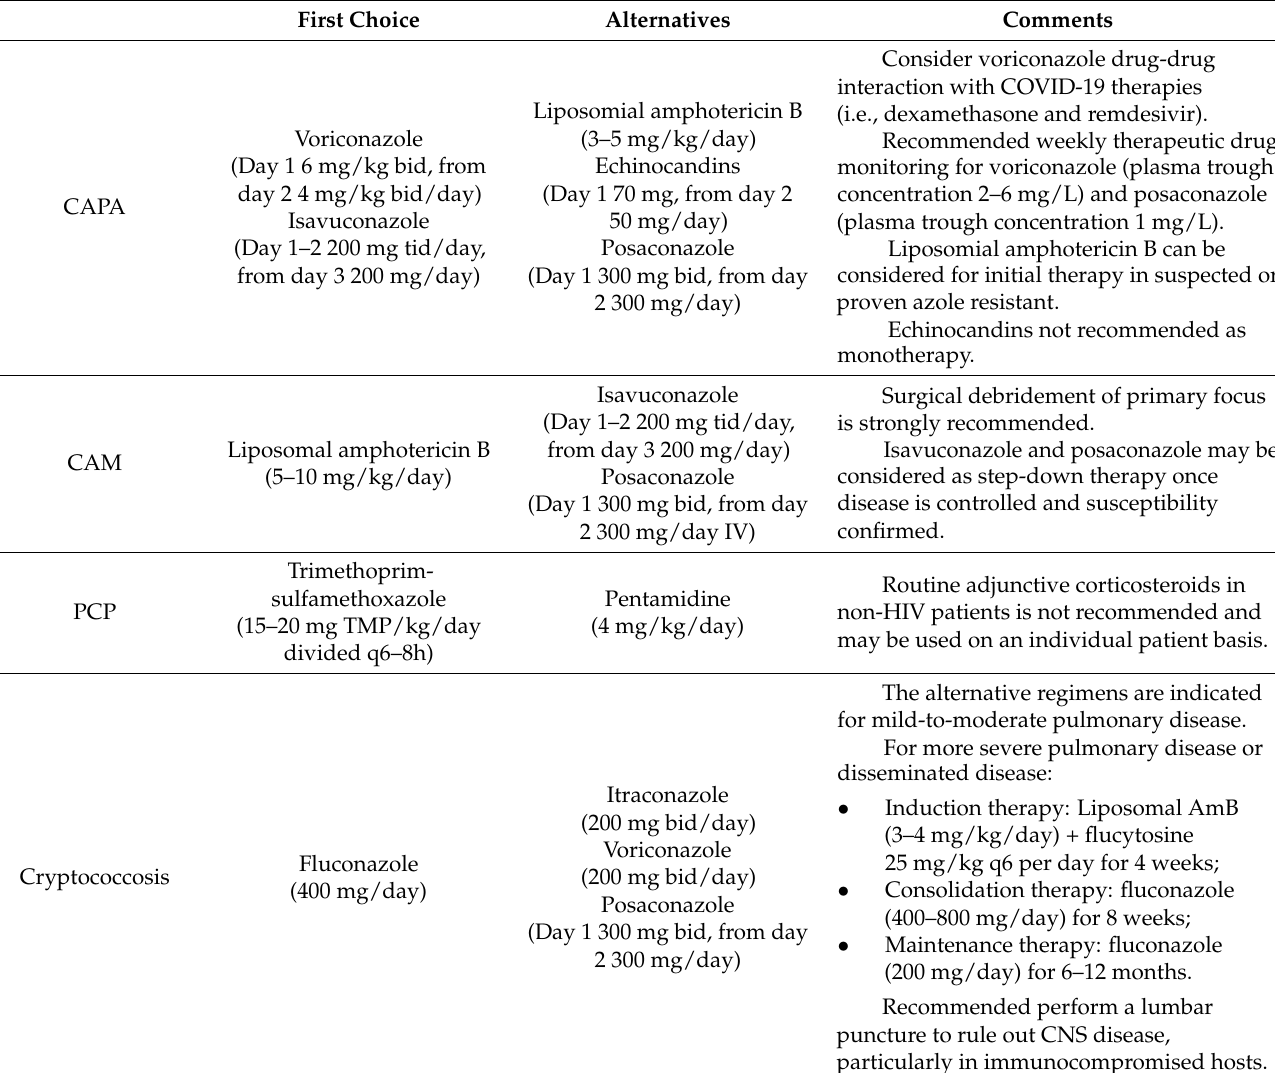
Table 1. Treatment of principal invasive respiratory fungal